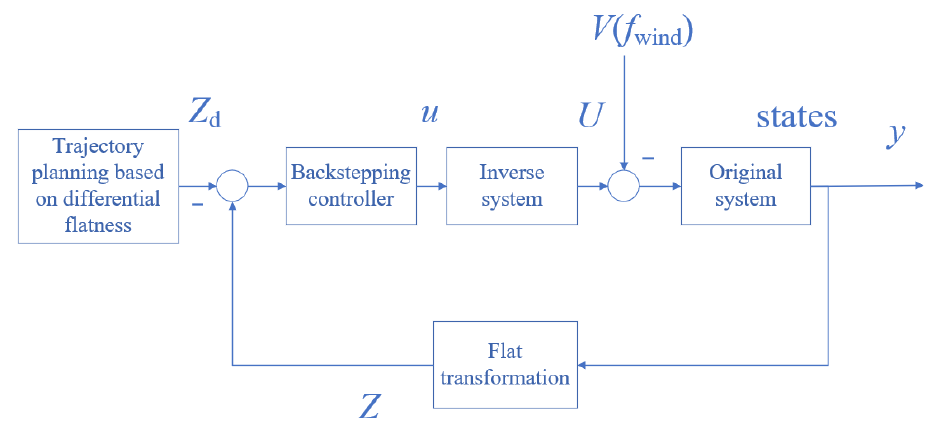
Figure 3. Control flow chart.